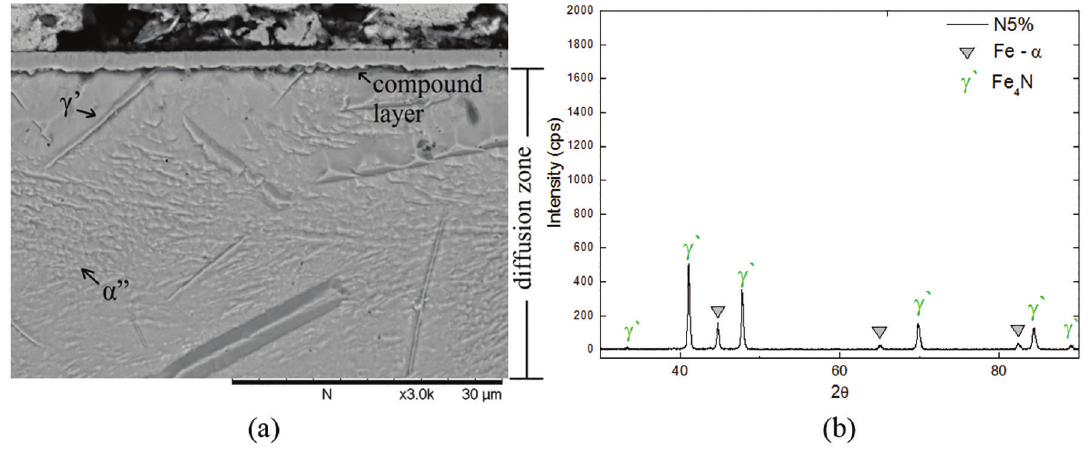
Figure 3: Sample N5%: (a) scanning electron microscopy image and (b) XRD.